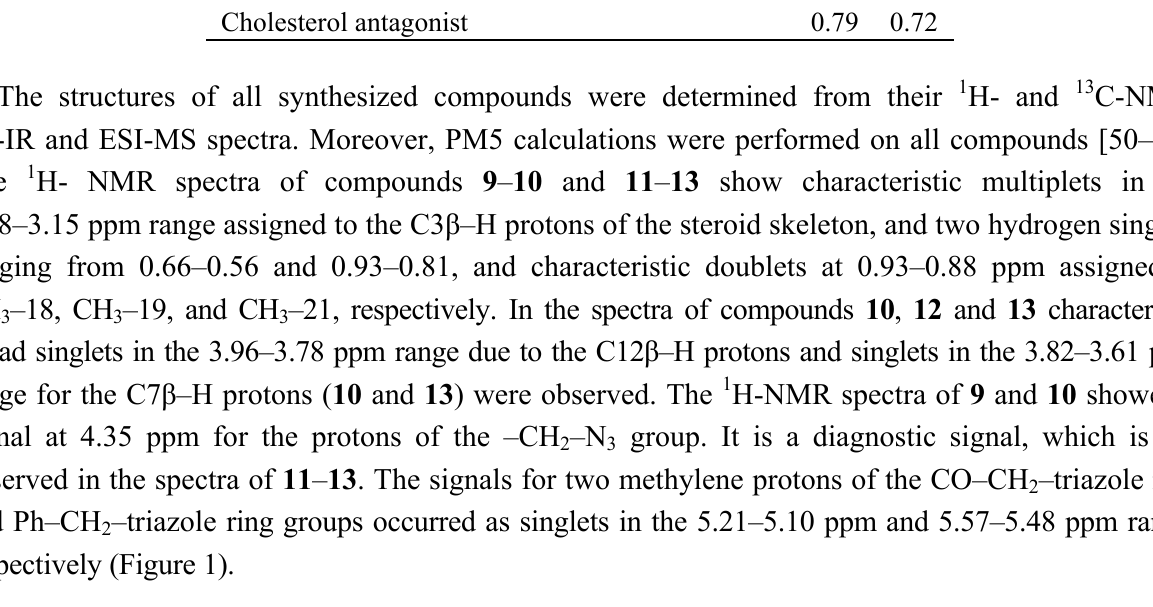
Figure 1. 1 H-NMR spectra in the region (7.8–3.55 ppm) of the most characteristic signals of compounds 9 and 13